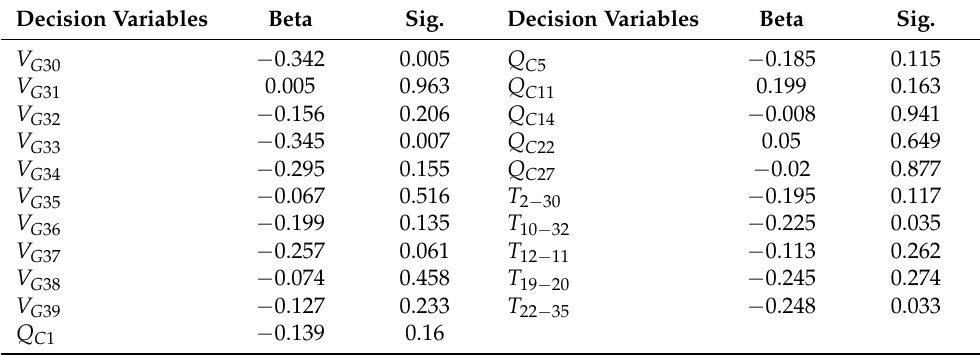
Table 10. Statistical significance of multiple tests runs for the IEEE 39 bus test system optimized by the proposed